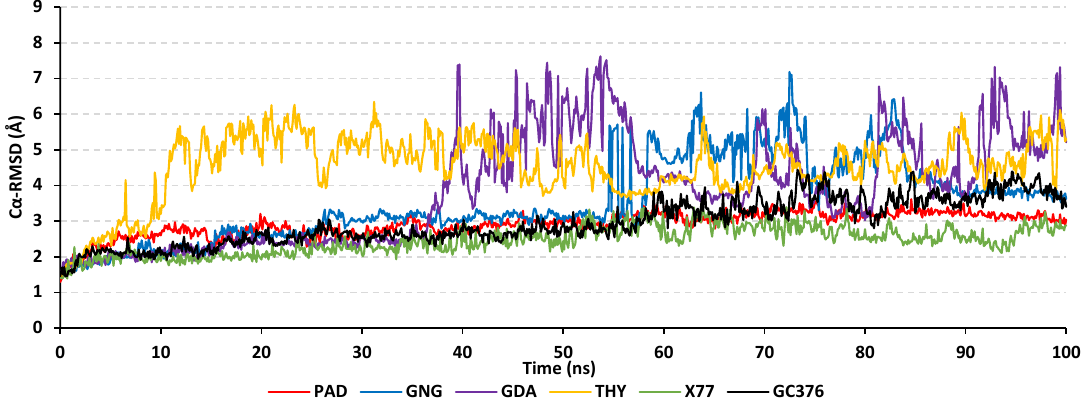
Figure 5. Stability analysis of the ligand-M PRO complex across the 100 ns explicit molecular dynamics simulation runs. The generated RMSD trajectories (Å) are represented across the simulation timeframes (ns).